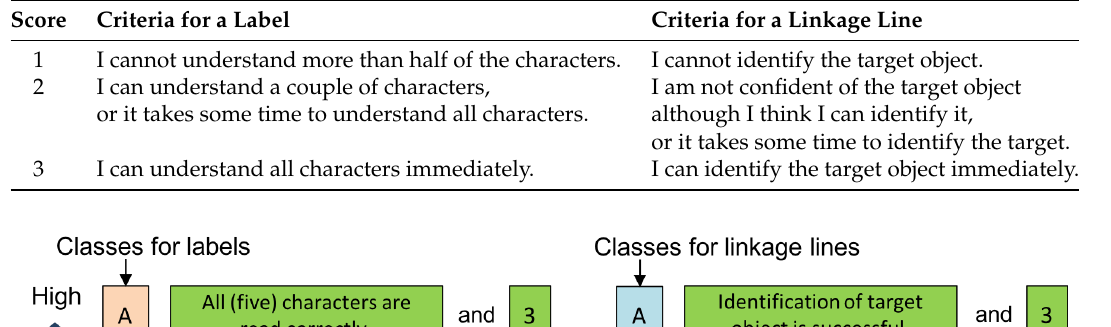
Table 1. Criteria for subjective measures.